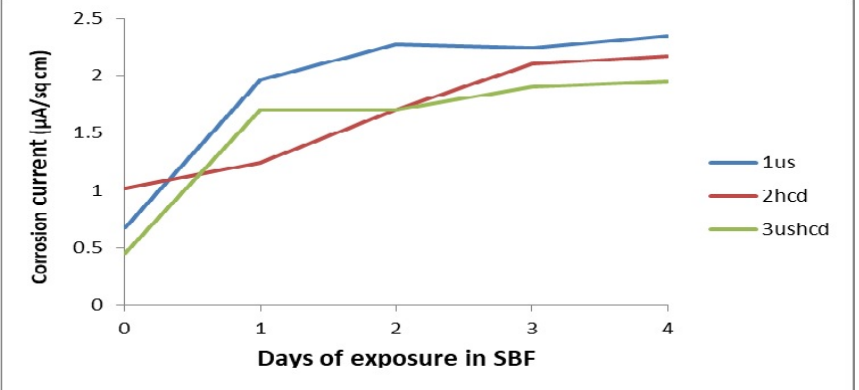
Figure 5. Variation of corrosion currents with time of exposure.